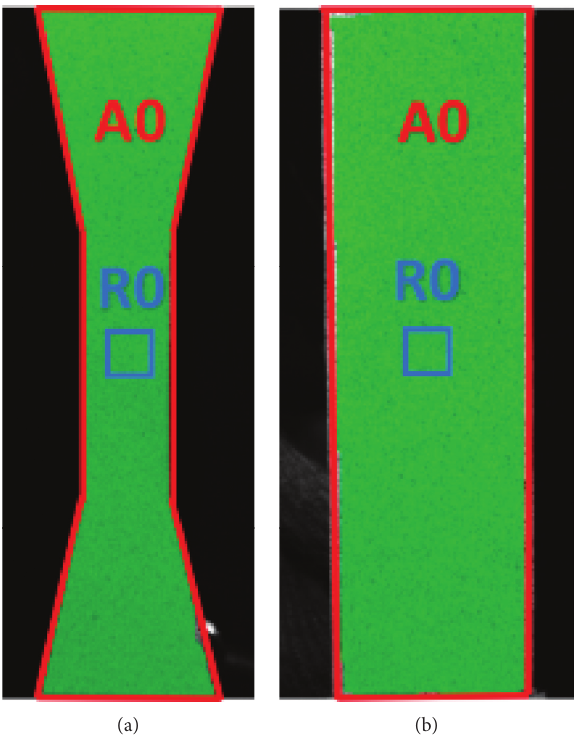
Figure 4: Data extraction area. (a) Dumbbell shape. (b) Strip shape.